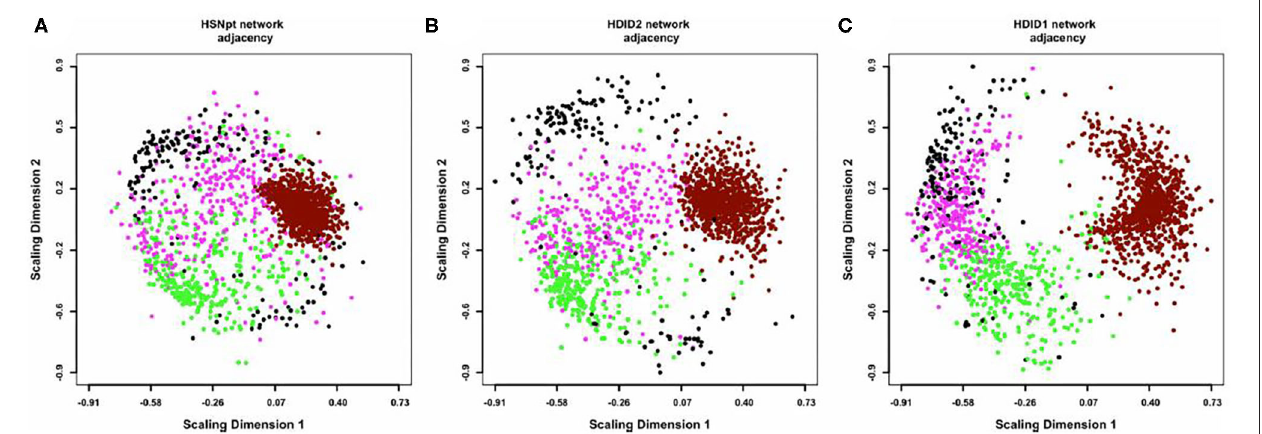
FIGURE 2 | Multidimensional scaling (MDS) plots of the coexpression networks in HS/NPT (A) , HDID-2 (B) , and HDID-1 (C) datasets. For visual clarity, only the 4 modules most consistently affected by selection (“black,” “magenta,” “dark-red,” and “green”) are depicted. Each dot represents a transcript, with colors corresponding to module assignments. The distances between points correspond to network adjacency. The figure illustrates (1) the modularity of the networks, with similar colors clustered together and (2) the effect of selection on the network structure, with HDID-1,2 diverging from the original HS/NPT network structure. In particular, the “dark-red” module appears more dispersed, while the “magenta” module appears more compacted in the selection networks. Figure reprinted with permission from ( 52).